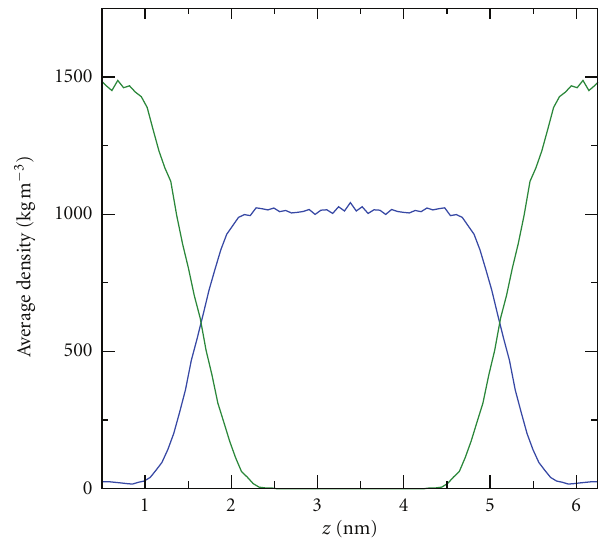
Figure 5: Average density profiles from the H 2 O-CHCl 3 system. Average density profile of water (blue line) and of chloroform (green line). The liquid | liquid interfacial system consists of two adjacent liquid slabs of 616 water molecules and 246 molecules arranged in a rectangular box of size 3.3 nm × 3.3 nm × 3.3 nm. All simulations were performed using the Gromacs package in the NpT ensemble at 298K and 1.00atm. Periodic boundary conditions were applied in all three directions of the Verlet Leapfrog algorithm which was used to integrate the equations of motion, with a time step of 2